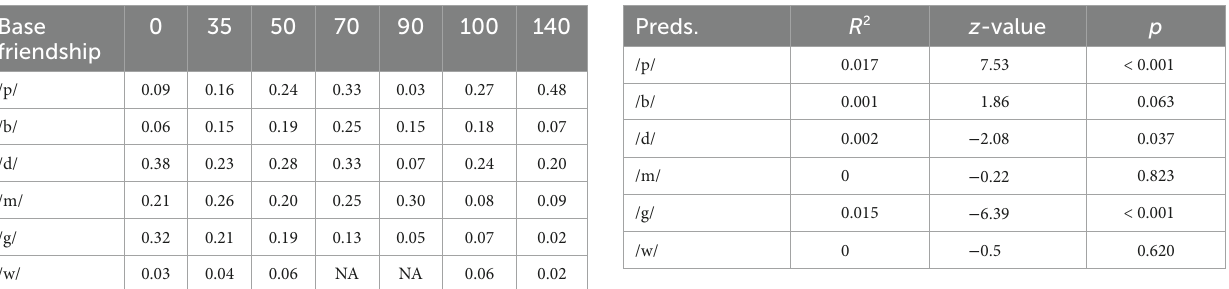
TABLE 3 Average number of times that each phoneme occurs in Pokémon names by base friendship level.